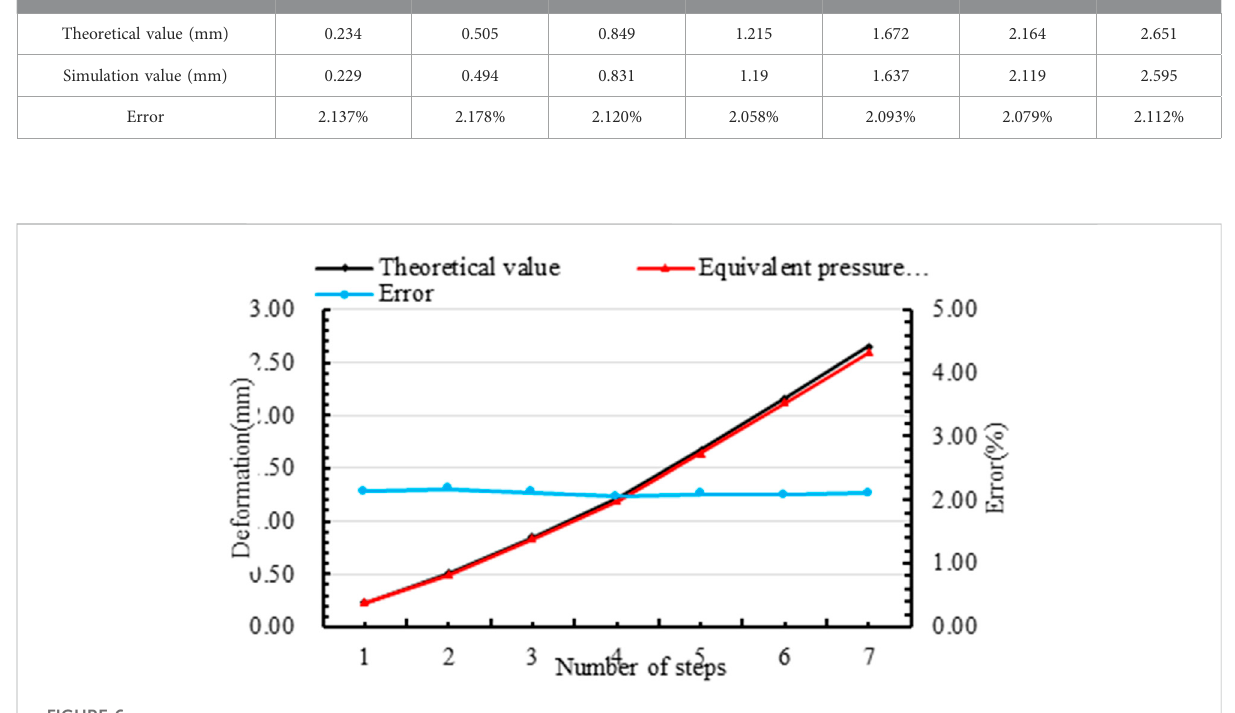
FIGURE 6 Equivalent pressure loading error